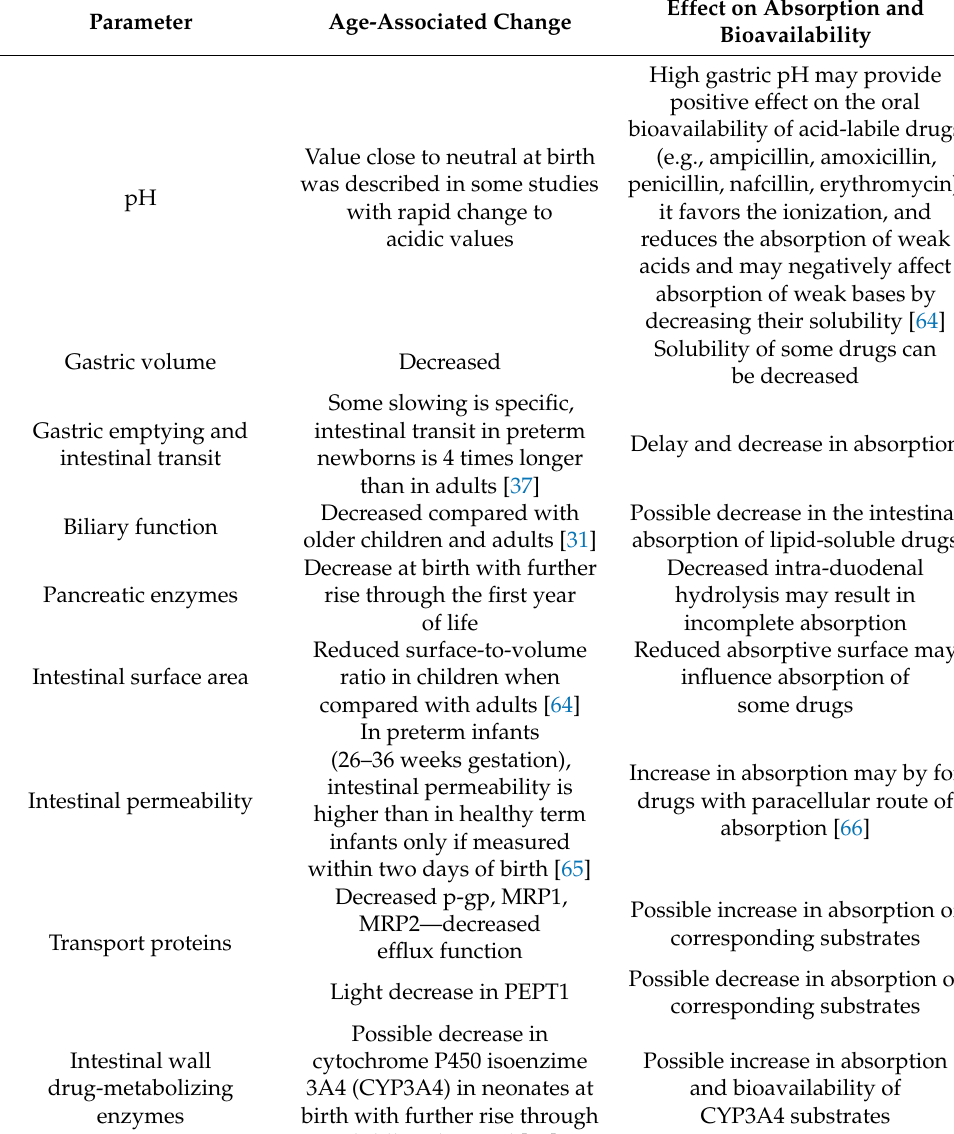
Table 2. The summary of GIT features in neonates and their effects on absorption and bioavailability of orally administered